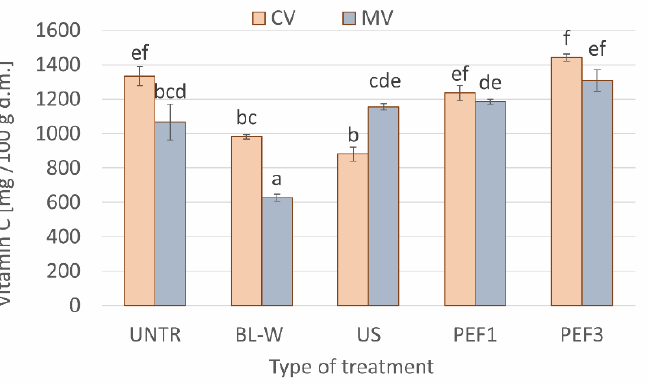
Figure 4. Comparison of vitamin C content for convective (CV) and microwave–convective (MV) dried red bell pepper subjected to thermal or non-thermal treatment prior to drying. Column presents a mean (from 3 repetitions), and errors bars show standard deviation. The different letters above columns show different homogeneous groups (Tukey’s HSD, α = 0.05).